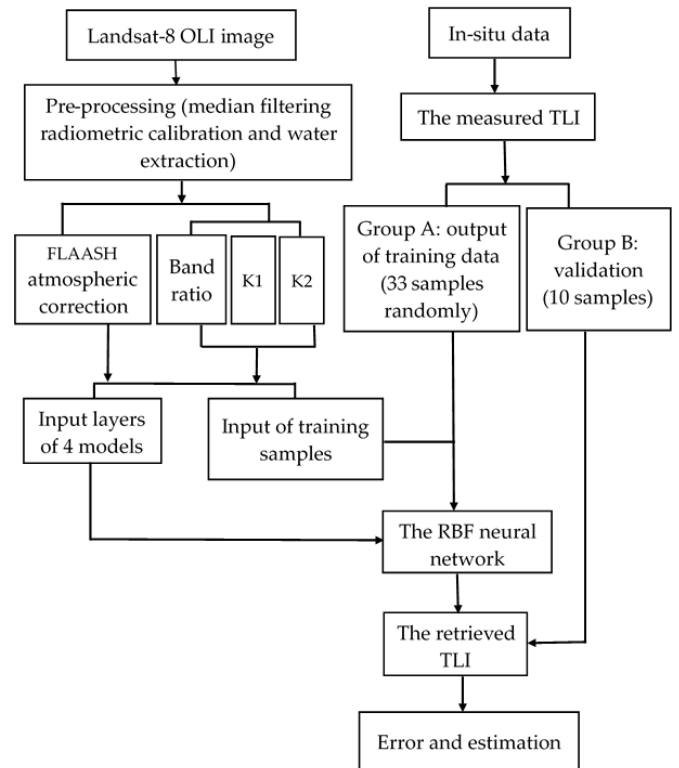
Figure 2. The workflow of this research.